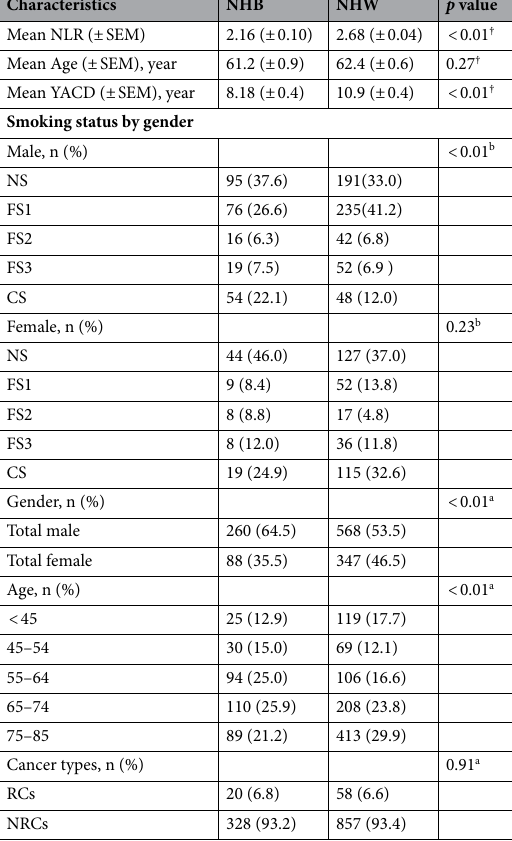
Table 5. NHB survivors had lower NLR levels than NHW survivors. † One-way ANOVA test found mean age is distributed differently between low-risk and high-risk NLR groups. a Rao-Scott Chi-square test. b Fisher’s exact test. SEM Standard error of the mean. NLR Neutrophil-to-lymphocyte ratio. CD Chronic diseases. BMI Body mass index. NHW Non-Hispanic White. NHB Non-Hispanic Black. NS Nonsmoker. FS1 Quit smoking 5 or more years before a cancer diagnosis. FS2 Quit smoking less than 5 years before a cancer diagnosis. FS3 Quit smoking after a cancer diagnosis. CS Continued smoking after a cancer diagnosis. RCs Respiratory cancers. NRCs Non-respiratory